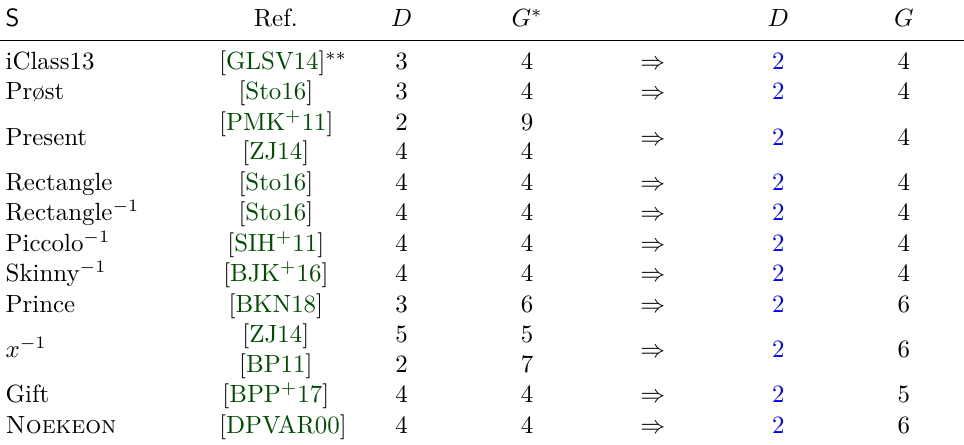
Table 3: Improvements over the